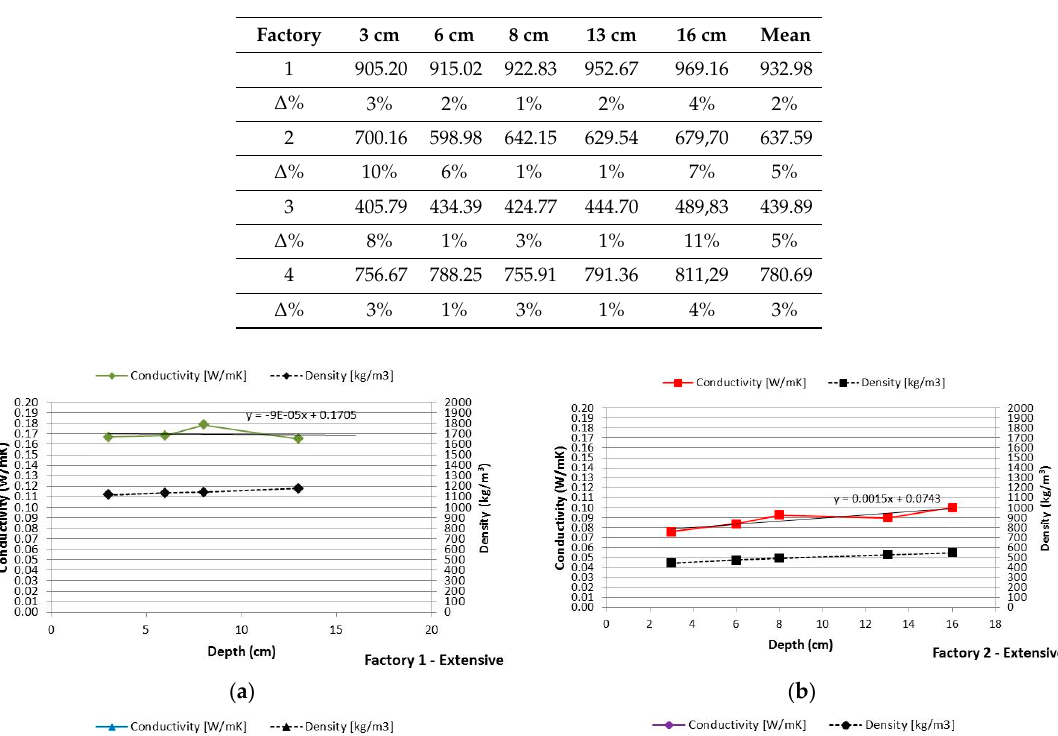
( d ) Figure 5. Dry thermal conductivity—intensive samples; ( a ) Factory 1, ( b ) Factory 2, ( c ) Factory 3, ( d ) Factory 4. The thermal resistance increases linearly along with the increase in the substrate thickness both for extensive and intensive samples, as shown in Figure 3. The 16 cm-thick samples show the greatest variation from the trend line in most cases, due to compaction problem during the laboratory tests.